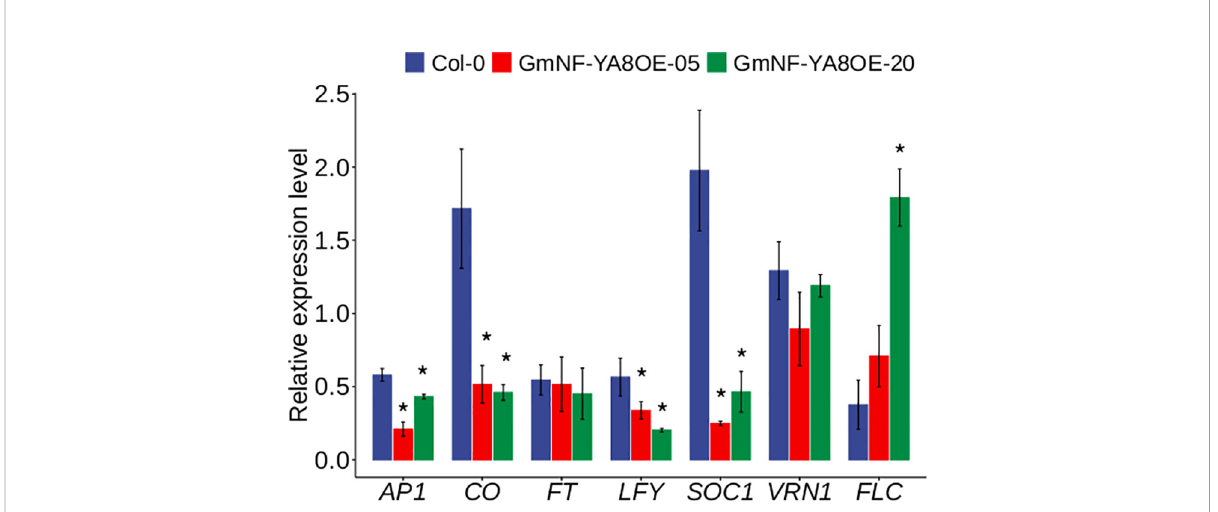
FIGURE 9 Effects of ectopic expression of GmNF-YA8 on the expression levels of fl owering-related genes in Arabidopsis . Results are means ± SE from three independent experiments. Student ’ s t - tests was used to compare the differences between Col-0 and the transgenic lines GmNF-YA8OE- 05 and GmNF-YA8OE-20 (* P <